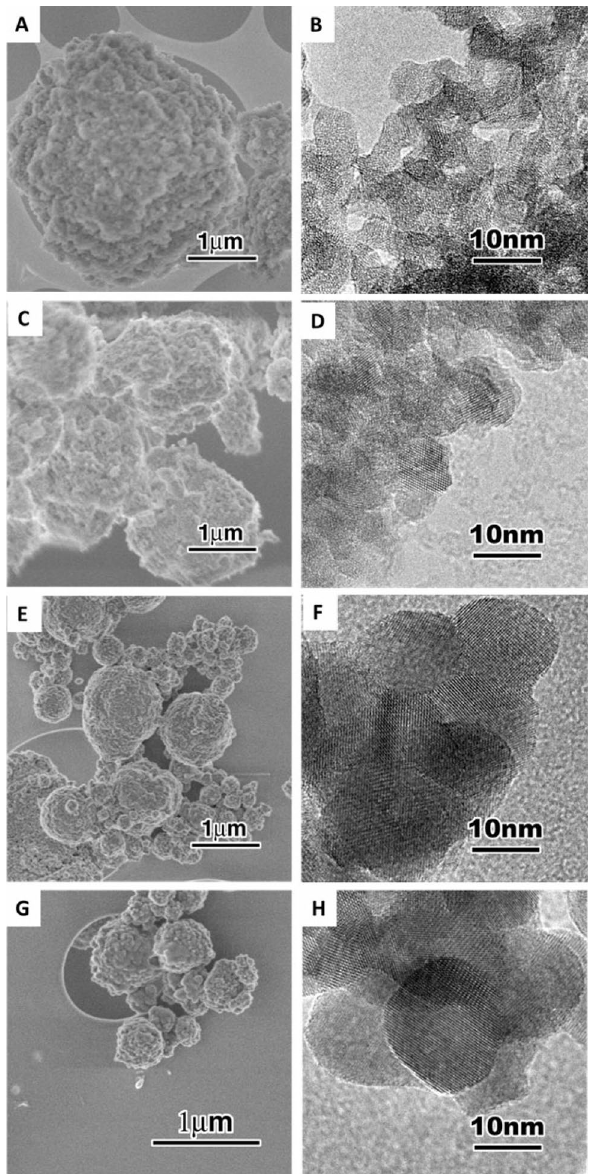
Fig. 7 SEM and TEM of salt-assisted spray dried ZrO c , d lCsZrO